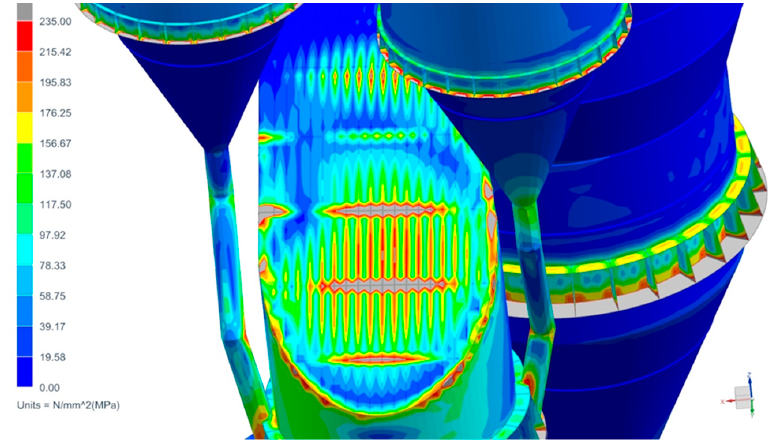
Figure 16. The stress pattern for the analysis accounting measured thickness, von Mises stresses MISSING.